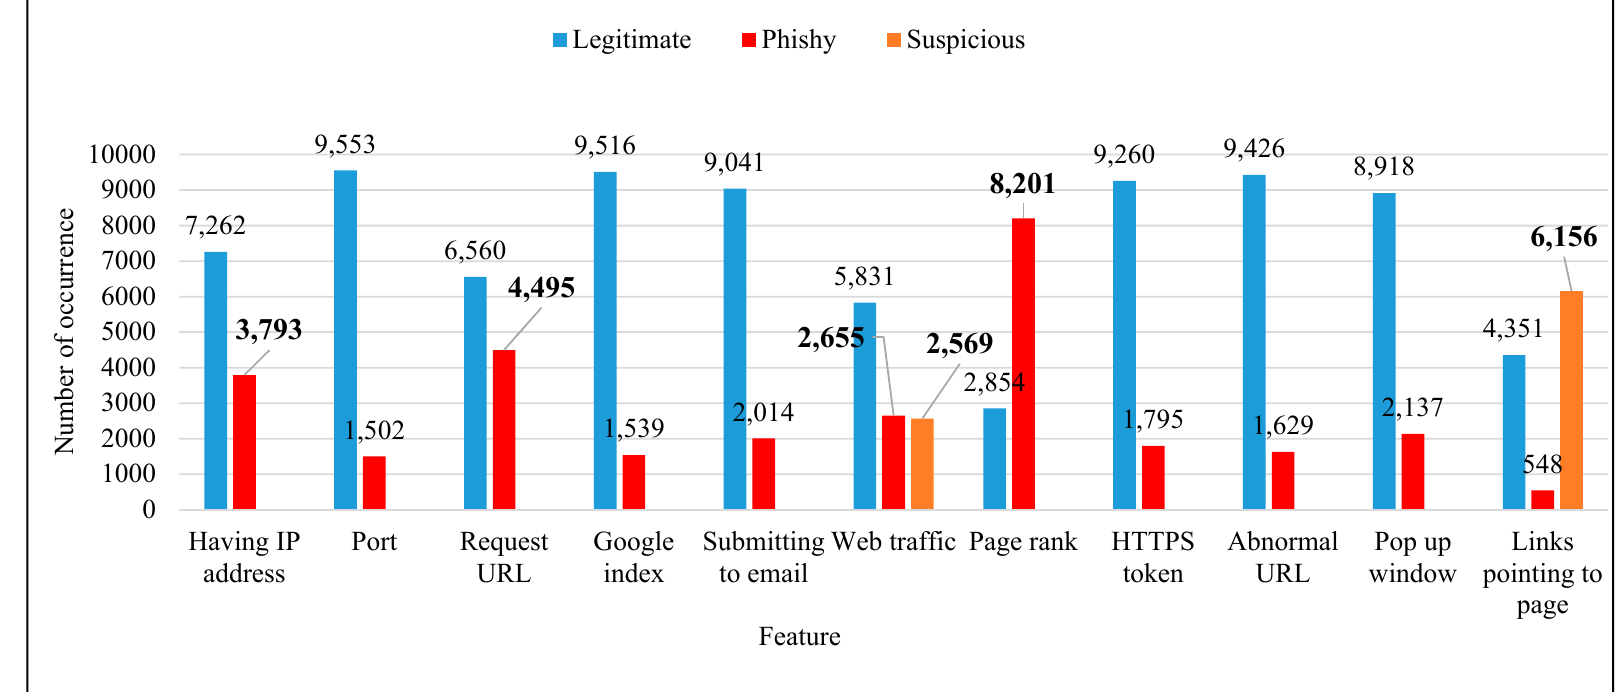
Figure 6. Number of occurrences of all features with comparison of legitimate, phishy and suspicious.